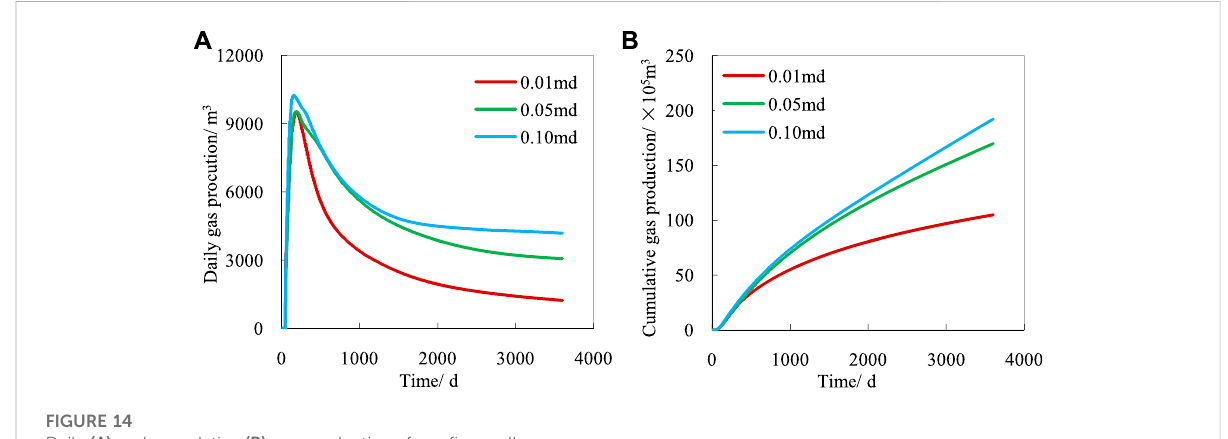
FIGURE 14 Daily (A) and cumulative (B) gas productions for a fi ve-well